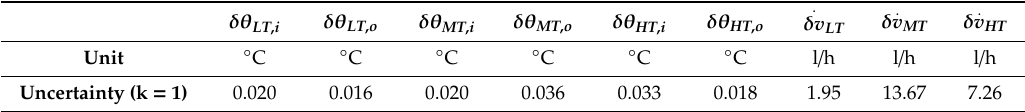
Table 3. Summary of the absolute uncertainties of the calibrated temperature and flowmeters with a coverage factor of k =